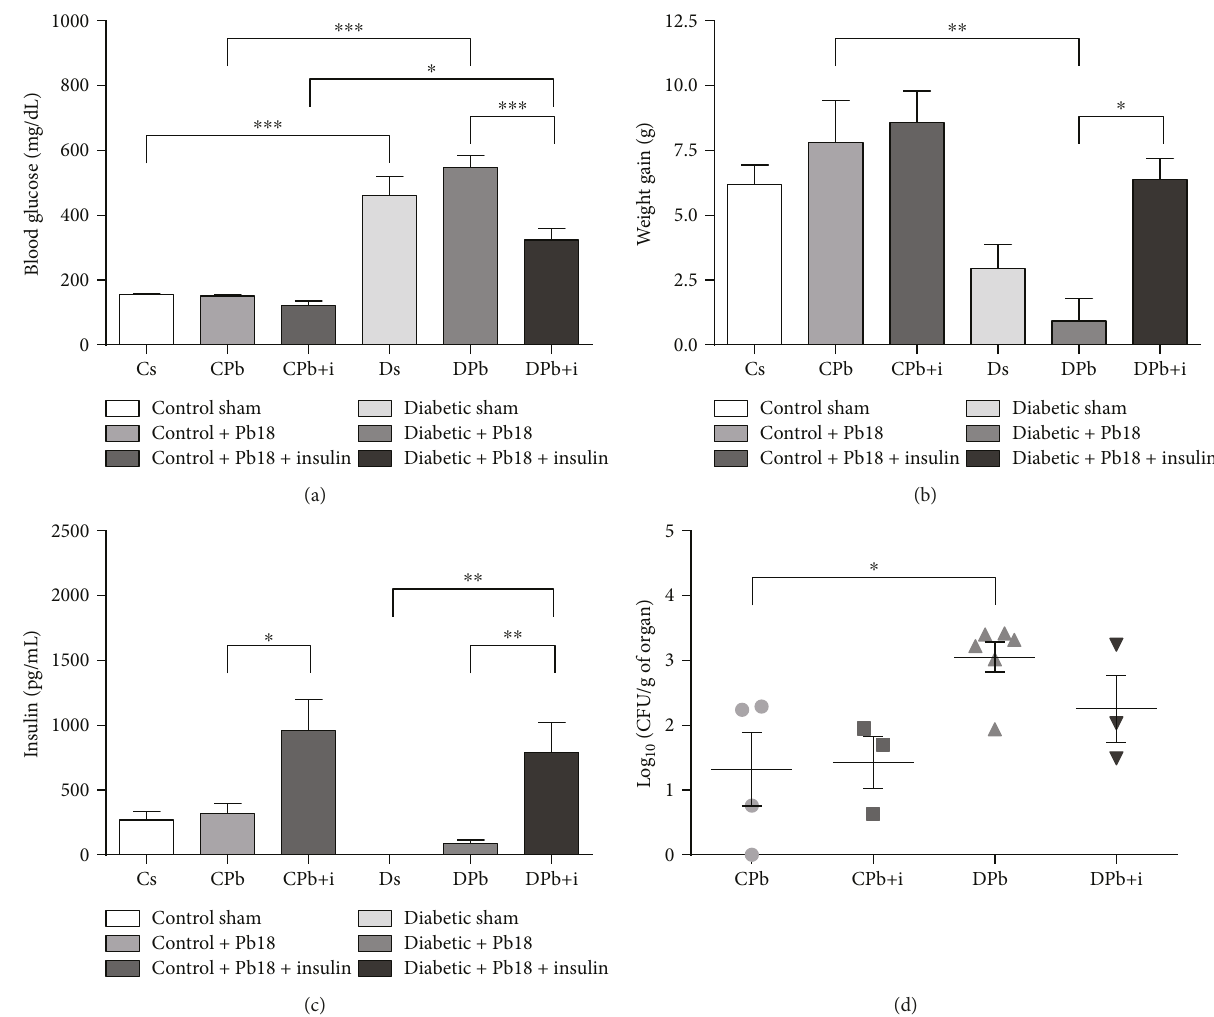
Figure 2: General characteristics of the animals. Mice were rendered diabetic via injection of alloxan (60mg/kg i.v.) and infected with P. brasiliensis (1 × 10 6 cells i.t.). Blood glucose levels and body weight gain in the diabetic and nondiabetic groups were determined 55 days after alloxan injection and again after the 45-day incubation period. Five animals were included in each group, and values are the means ± SEM. (a) Blood glucose levels after 55 days. (b) Body weight gain after 55 days. (c) Insulin levels in serum. (d) Colony-forming unit count. ∗ p < 0 05 ; ∗∗ p < 0 01 ; ∗∗∗ p < 0 001